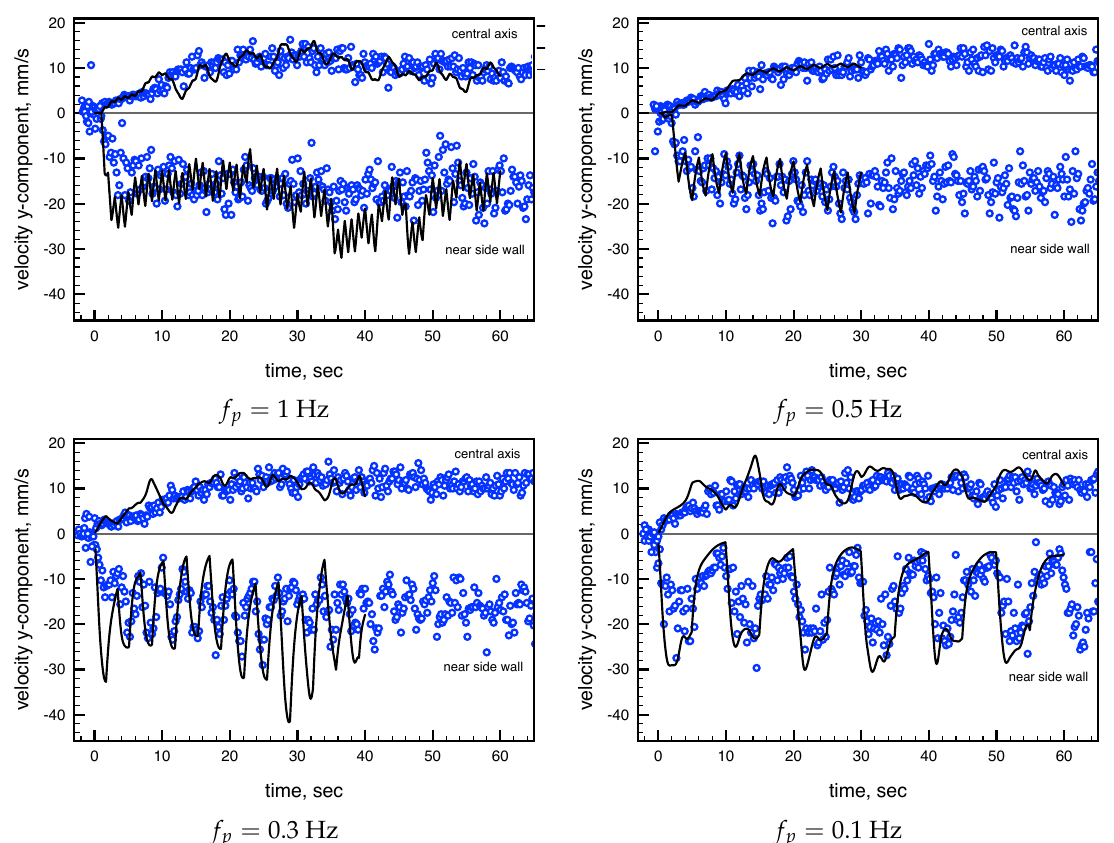
Figure 10. Spin-up liquid metal velocities at different pulsation frequencies. Dots–measured; lines–calculated. Video files of simulations can be found at supplementary data http://dx.doi.org/10.